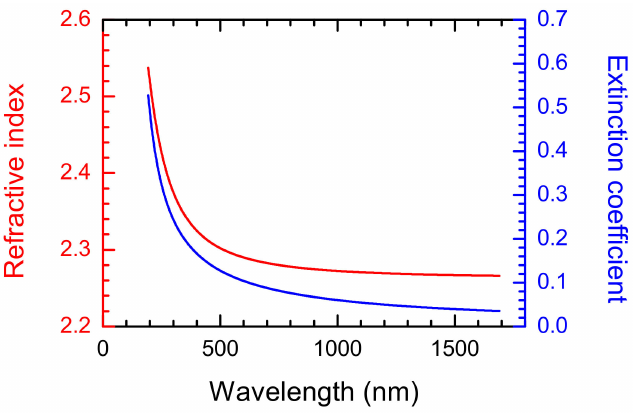
Figure 1. Optical constants of the MW PECVD polycrystalline diamond plate.